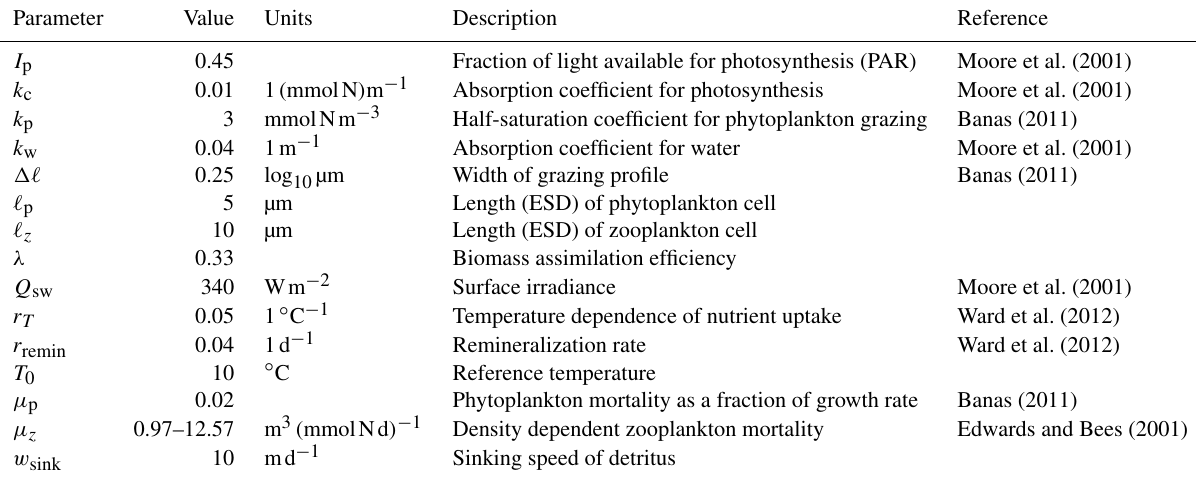
Table 1. Parameters and values used in the ecosystem model implemented in MAMEBUS. Coefficients without explicit references are chosen by the user.